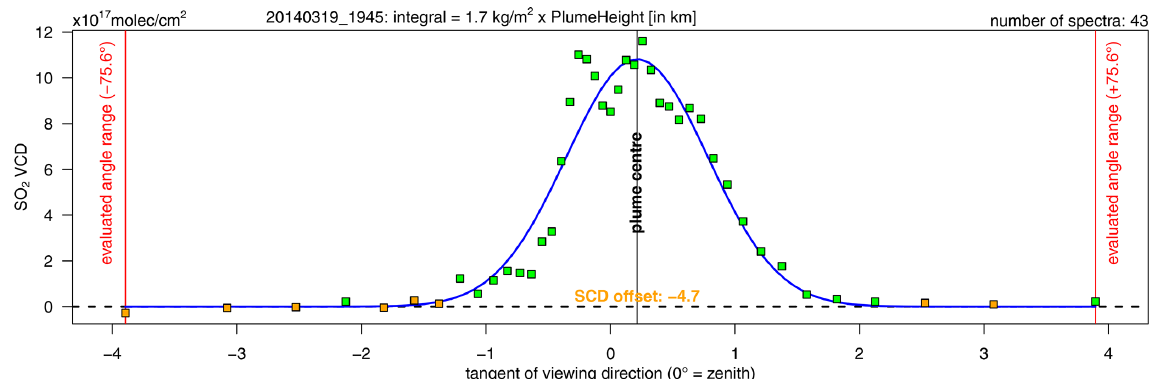
Figure 4. SO 2 VCD distribution retrieved from the scan starting at 19 March 2014 19:45UTC recorded at Caracol station. The green and orange squares give the retrieved angular SO 2 VCD distribution. Only data for zenith angles between − 75 . 6 and + 75 . 6 ◦ were considered. The orange squares were used for the retrieval of the background SCD (the set of the lowest SCDs does not necessarily match perfectly with the set of the lowest VCDs). The (negative) background SCD is given in orange. The plume centre is retrieved via the Gaussian fit (solid blue line). Table 3. Applied DOAS fit scenarios. The two lowest lines give the parameter ranges of the Levenberg–Marquardt fit routine. See Appendix B for the chosen wavelength range of the SO 2